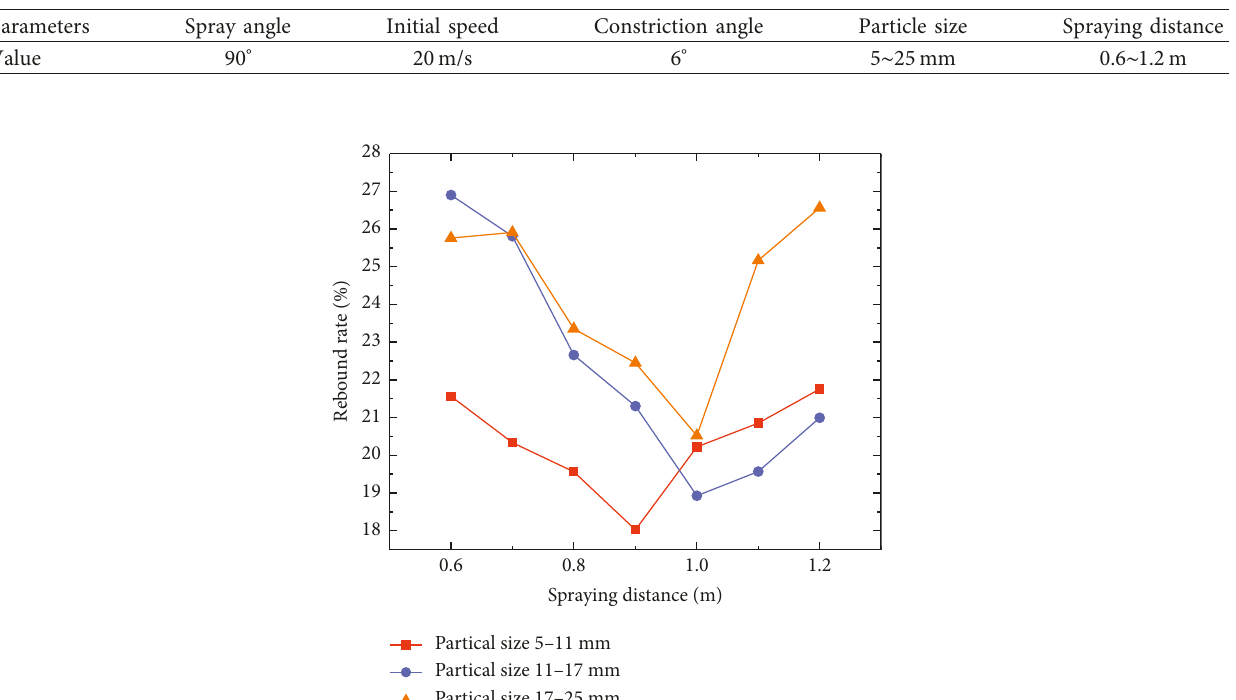
Table 7: Parameter setting table.